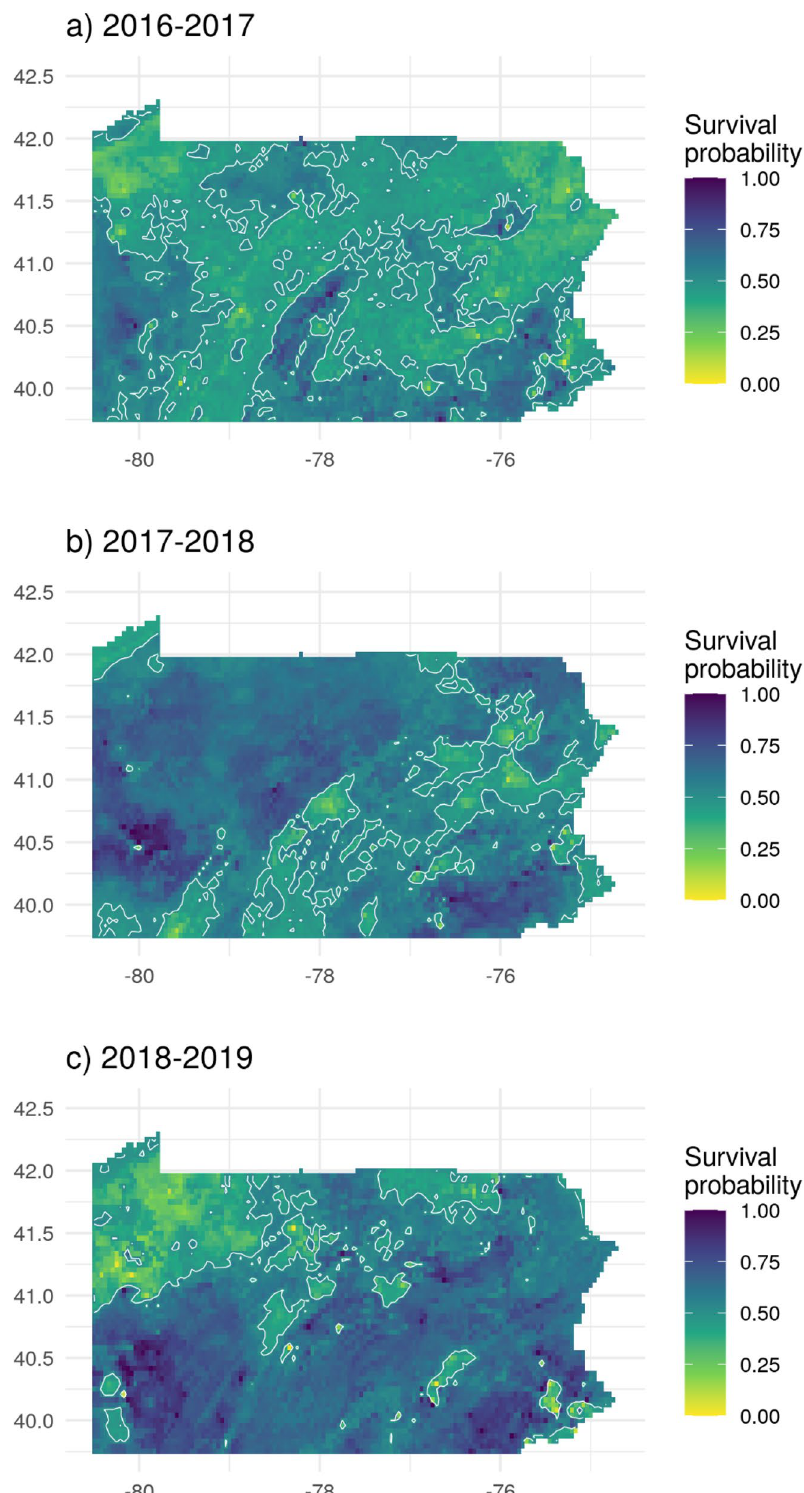
Figure 5. Weather-based prediction maps of the probability of honey bee colony survival from the weather-only colony model for the most recent 3 years of PRISM data. Contour lines show the 0.5 probability level. The three maps show the survival probability for Pennsylvania, based on the results of the weather-based model. The map ( a ) represents results from year 2016, which had a mean annual temperature of 10.4 °C and a mean annual precipitation of 1007 mm across the state. Map ( b ) represents results from year 2017, which had a mean temperature of 10.2 °C and a mean annual precipitation of 1205 mm. Map ( c ) represents results from year 2018, which had a mean annual temperature of 9.7 °C and mean annual precipitation of 1653 mm. For the whole period of record, from 1981 to 2018, the mean annual temperature was 9.4 °C, with a mean annual precipitation of 1082 mm. The maps have been generated by the authors in R 3.6.2 50 , using the sf 72 , the raster 56 , the ggplot2 73 and the cowplo 74